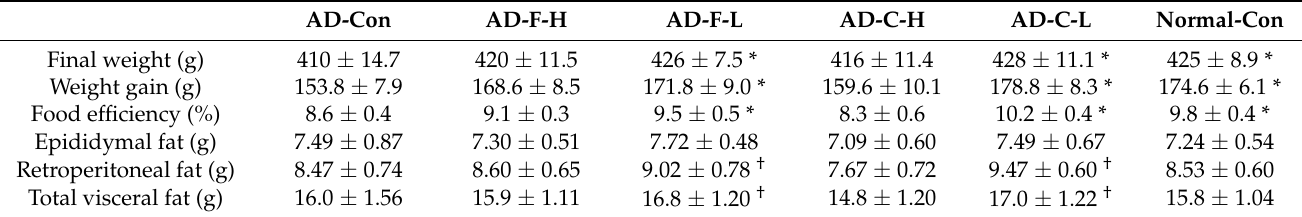
Table 1. Body composition and food intake at the end of experimental periods. AD-Con AD-F-H AD-F-L AD-C-H AD-C-L